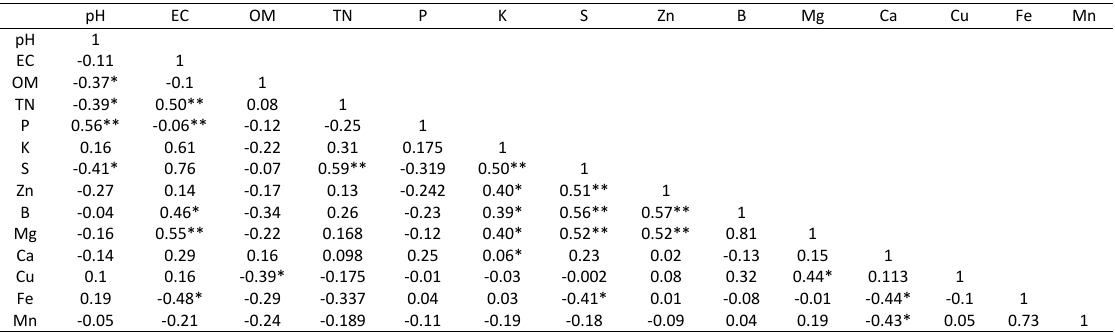
Table 4: Correlation coefficients matrix among 14 soil properties